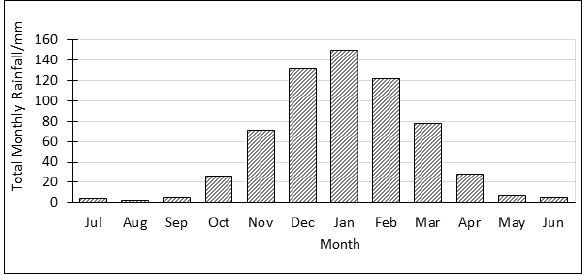
Annual cycle of rainfall (mm/month) in Zimbabwe for the period 1980 to